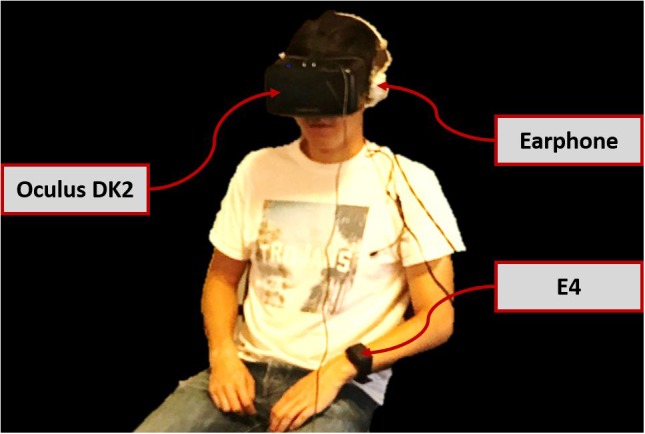
System apparatus.